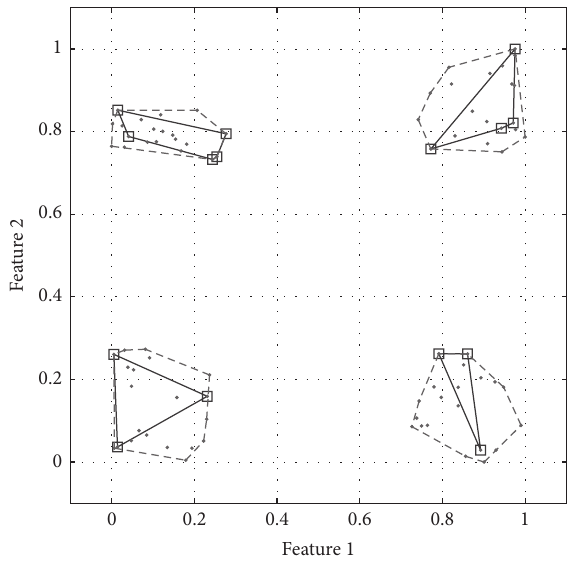
Figure 3: An example of CH algorithm result in a synthetic 2D case: continuous lines represent the convex hull really computed by the CH algorithm in order to build the MF of each fuzzy cluster; dashed lines represent the virtual convex hull that bounds each